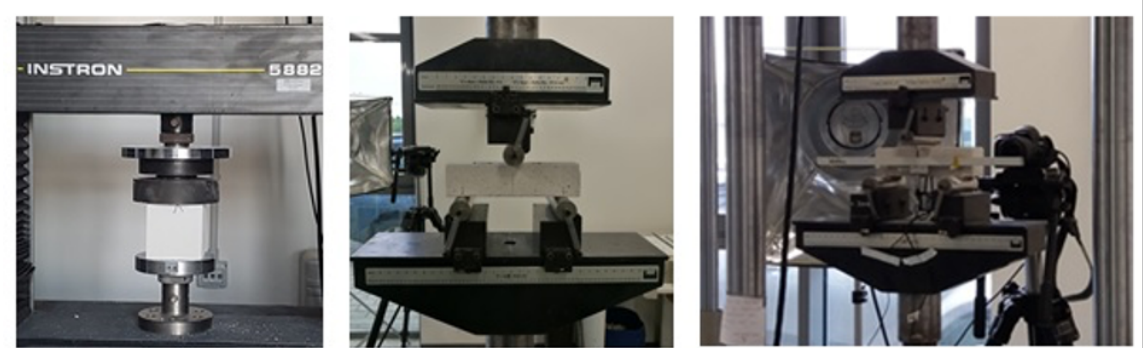
Figure 2. Test setup for the determination of: (a) compressive strength; (b) flexural tensile strength; (c) fracture